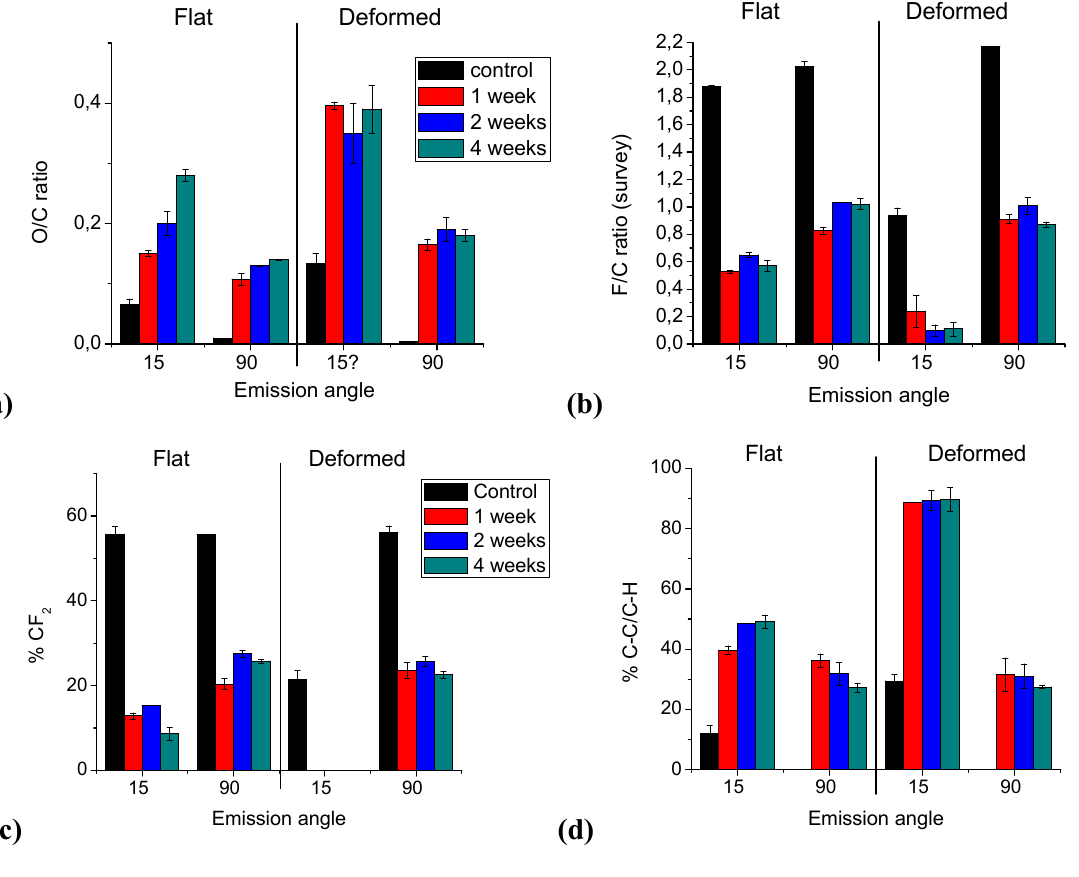
Figure 3. Ratios of (a) O/C and (b) F/C deduced from XPS survey data and XPS C(1s) and (d) % C-C/C-H as a function of ageing time, high resolution data for (c) % CF 2 measured at two emission angles (15° and 90°) for flat and deformed